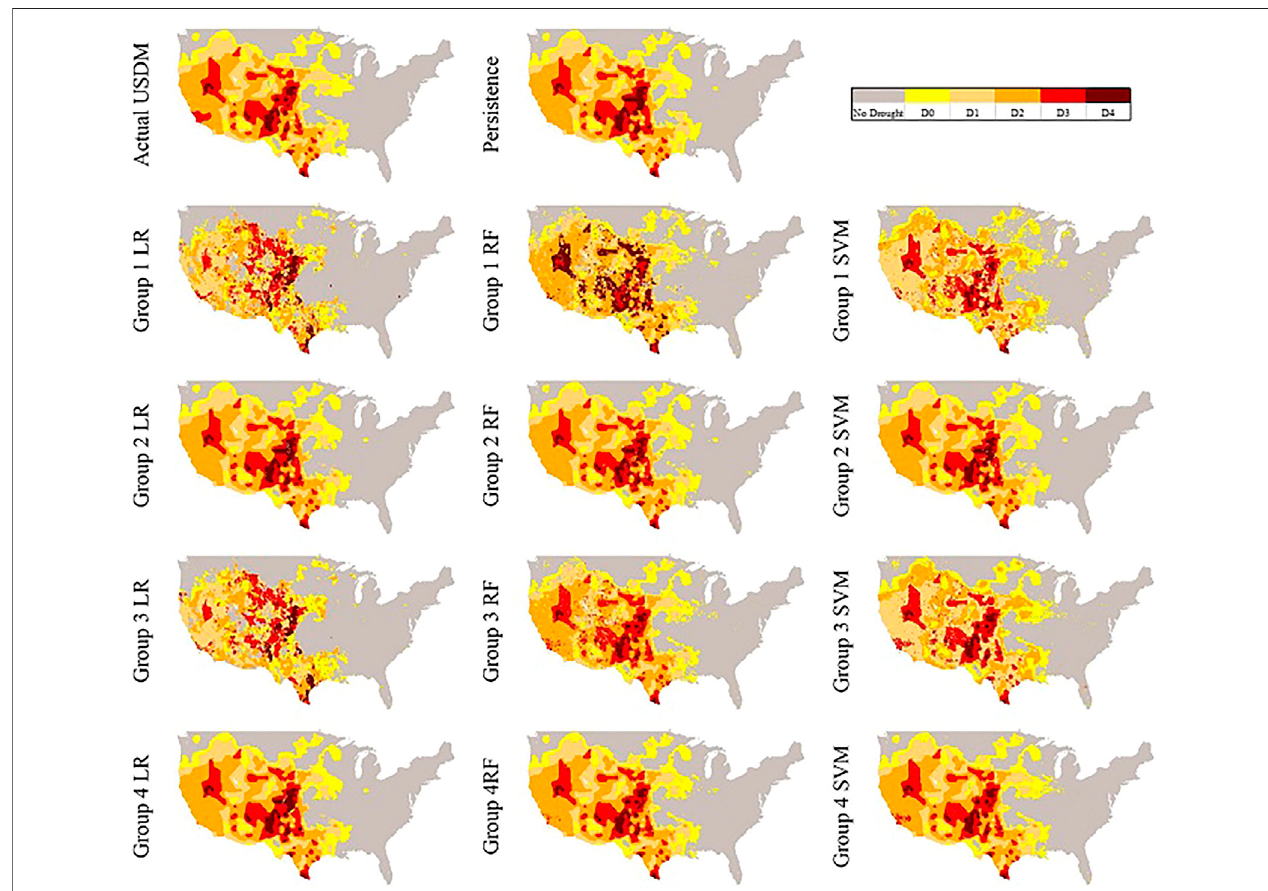
FIGURE 7 | Produced maps of 08/13/2013 by each model.